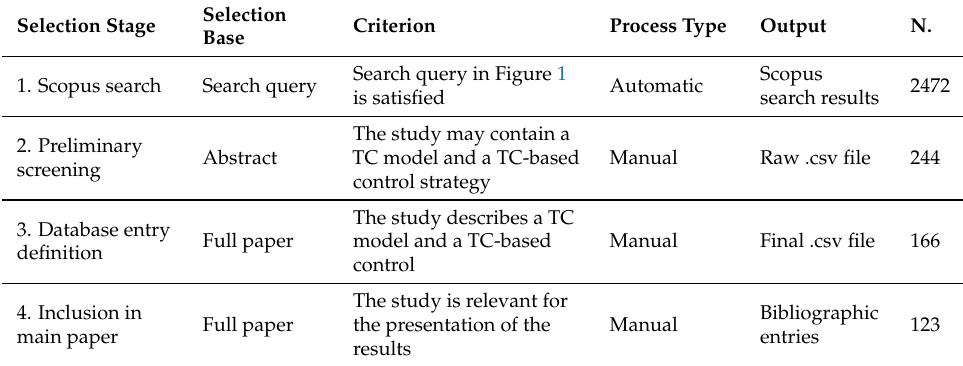
Table 1. Criteria used for paper selection (TC: thermal comfort). Selection